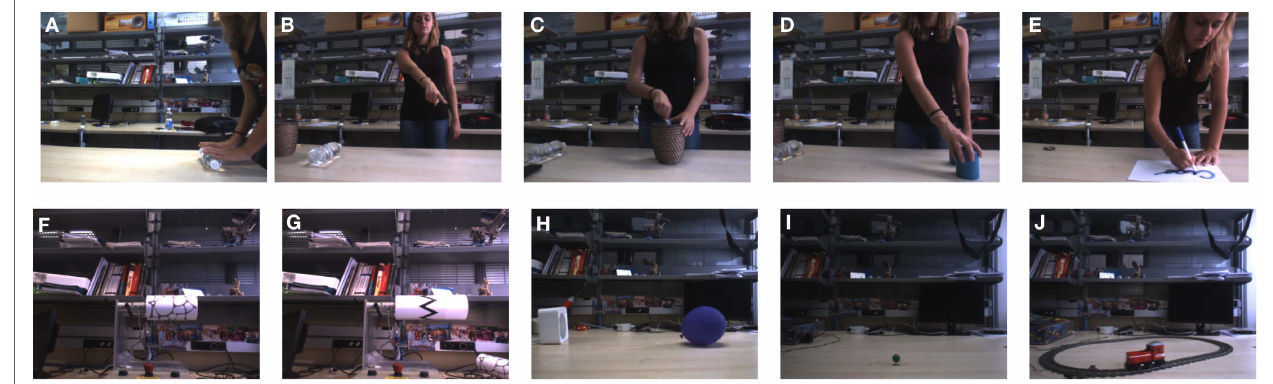
FIGURE 3 | Biological and non-biological movements included in the training set . (A) Rolling dough, (B) pointing, (C) mixing in a bowl, (D) transporting, (E) writing, (F) wheel (random pattern), (G) wheel (zig-zag) pattern, (H) balloon, (I) toy-top, and (J) toy train.